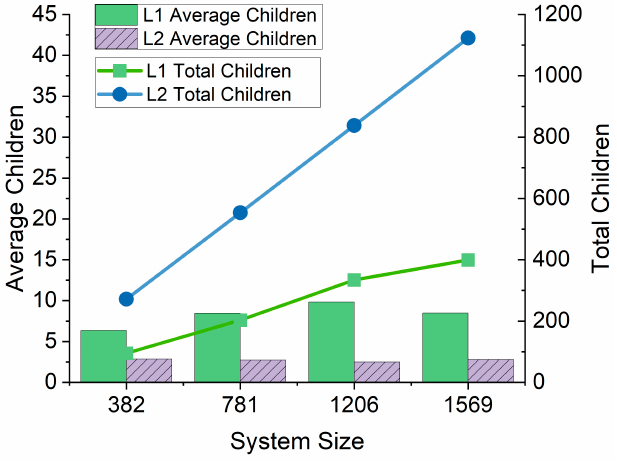
Figure 12. Maintenance overhead at different system sizes.